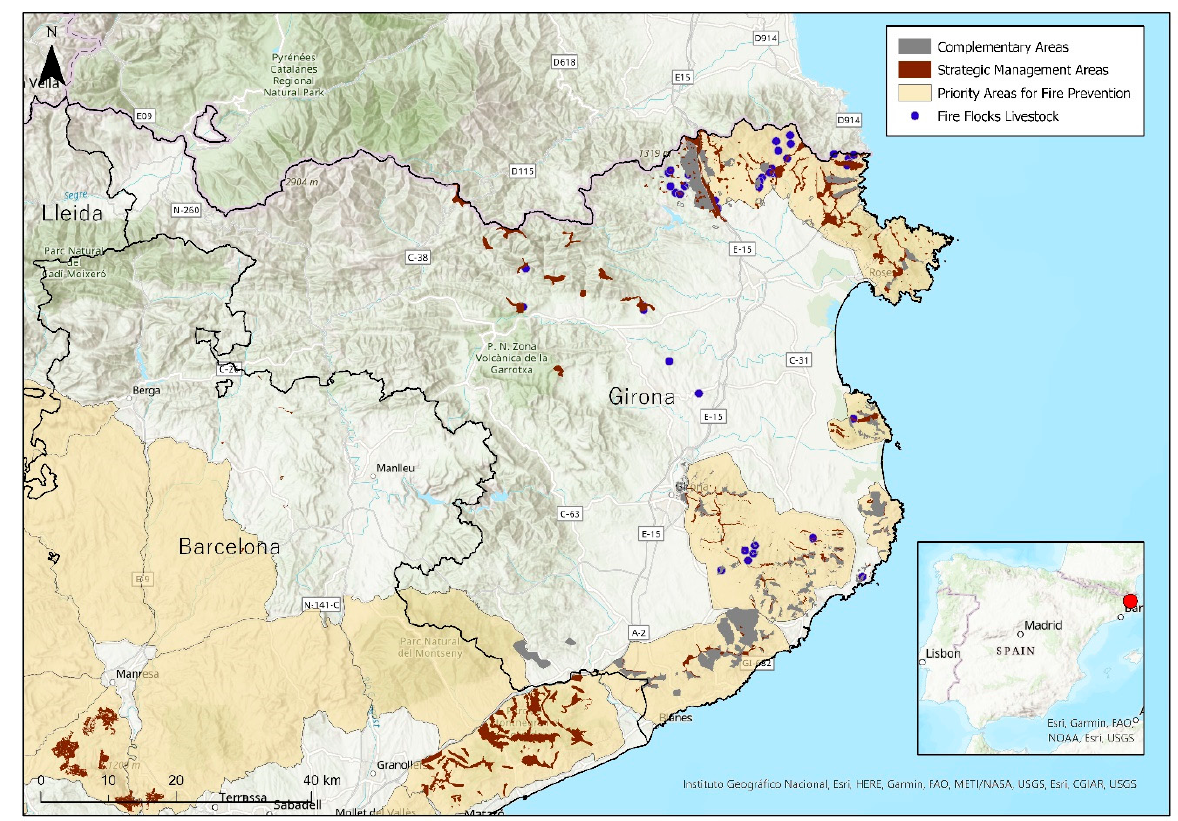
Figure 2. Map of Girona province highlighting Strategic Management Areas (SMAs, orange), Priority Areas for Fire Prevention (beige), and Fire Flocks stands (dots).